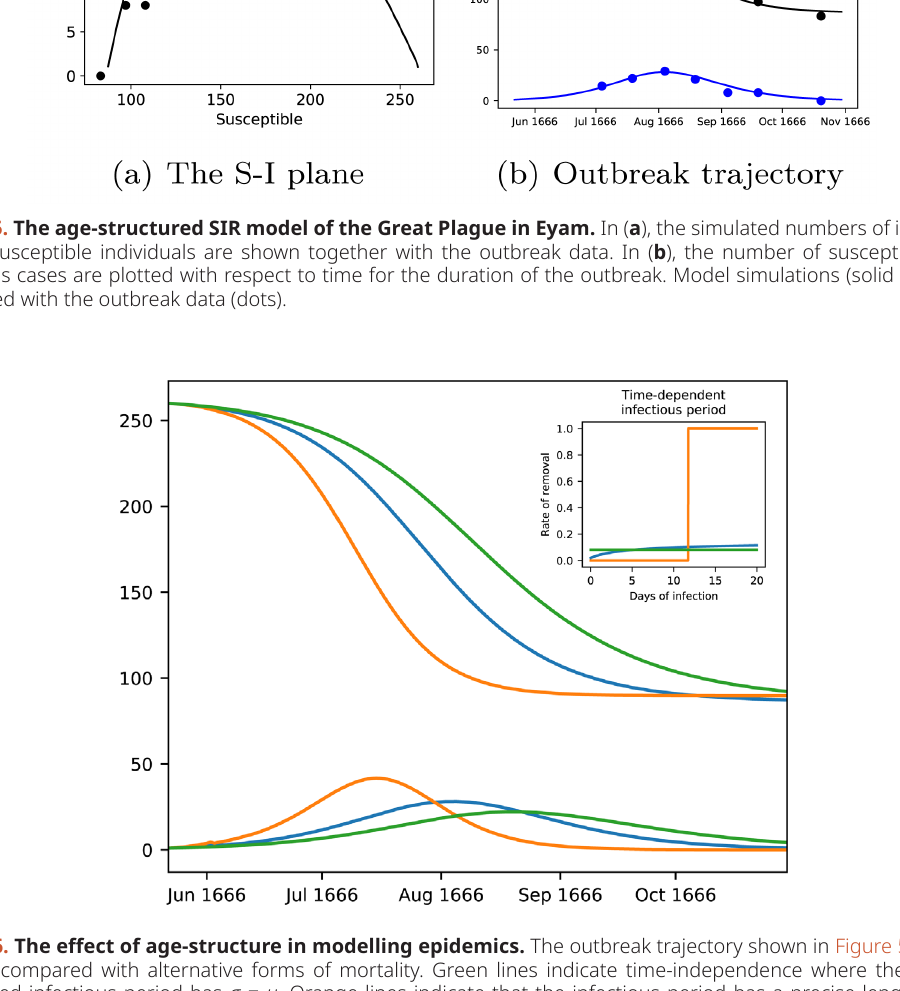
both deterministic and stochastic dynamics. In order to promote applications, three versions of the model were implemented: the and implementations are aimed at educational and introductory level use, while R Python the implementation offers further optimisation and high-speed simulations. This paper demonstrated that C the model is capable of representing age-structured population dynamics in different contexts including insect population dynamics, host-parasite/prey-predator interactions, and infectious disease epidemiology. Future research concerns optimising the implementation for faster simulations, implementing the model in con- tinuous time domain for improved accuracy, and incorporating accumulative development processes under varying environmental conditions for a broader and more accurate representation of biological